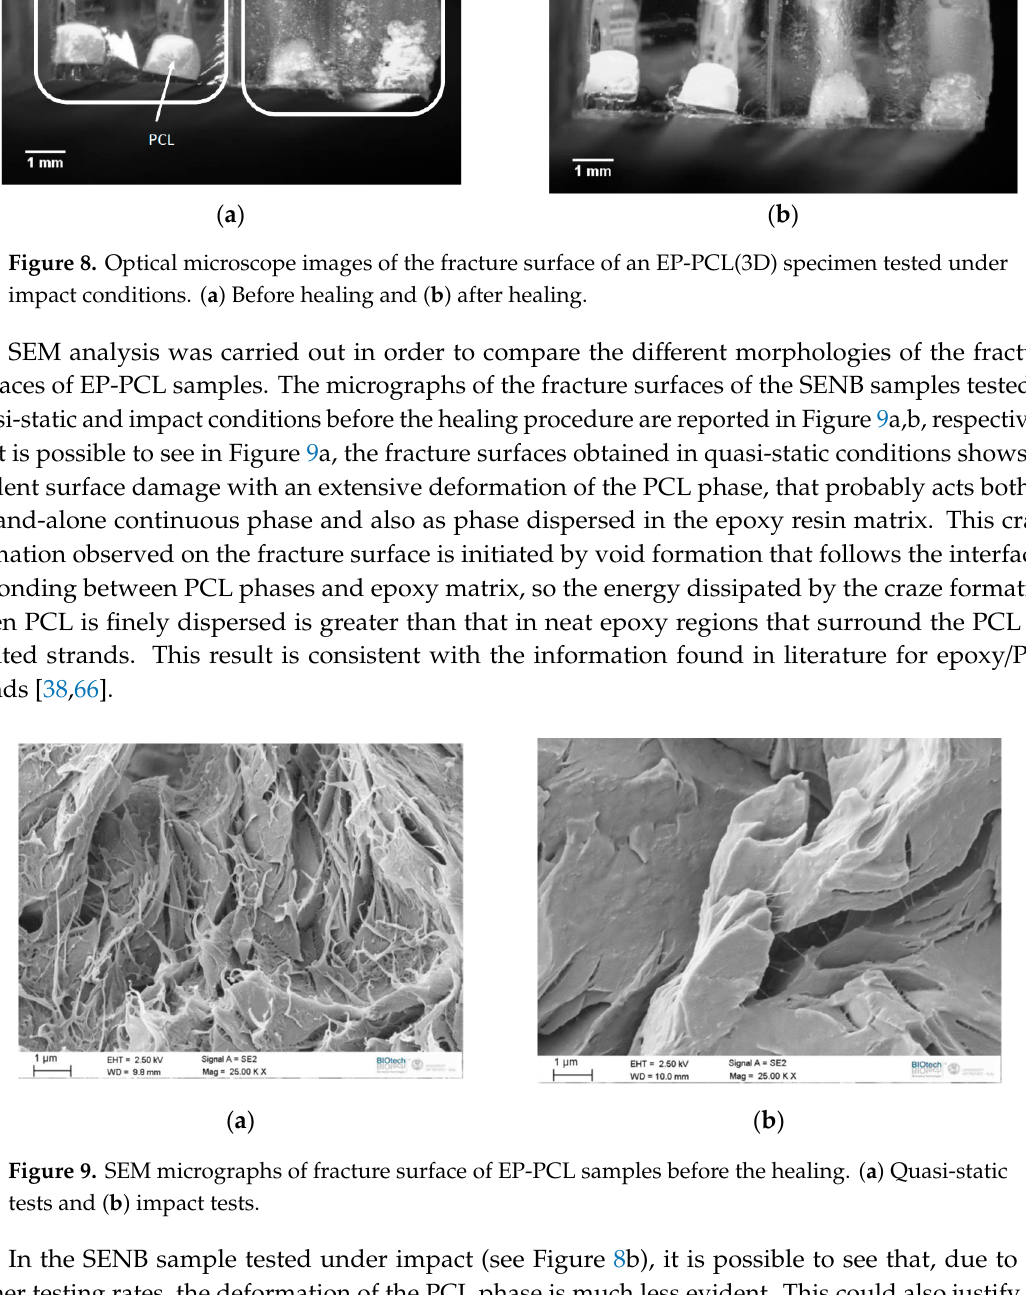
Figure 9. SEM micrographs of fracture surface of EP-PCL samples before the healing. ( a ) Quasi-static tests and ( b ) impact tests.